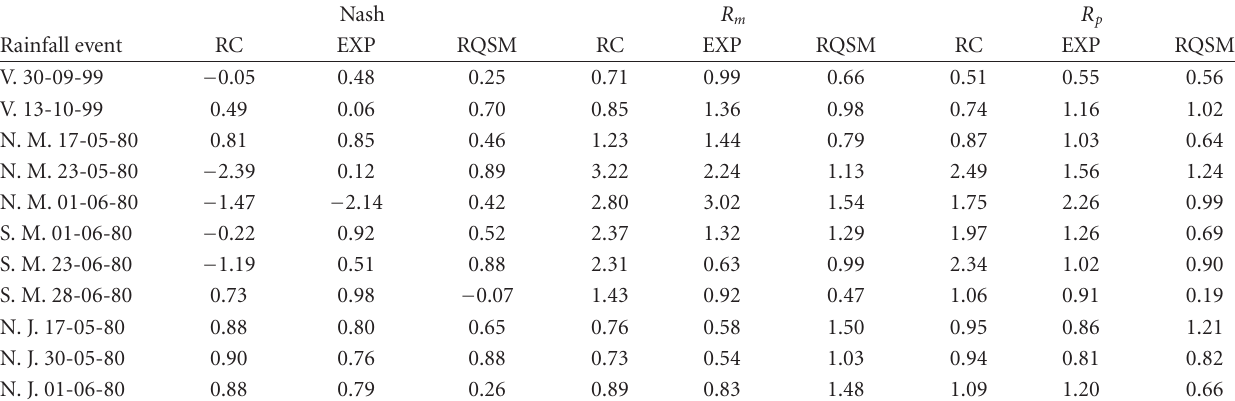
Table 4: Performance criteria values after particle load simulation with the RQSM, Rating Curve (RC), and Exponential (EXP) models. Nash R m R p Rainfall event